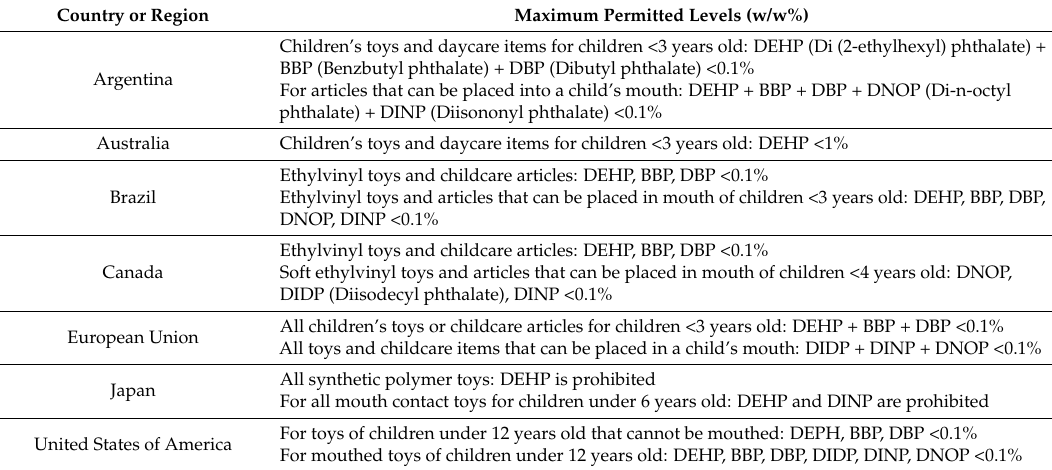
Table 1. Examples of national regulatory limits for phthalate composition of children’s toys. Country or